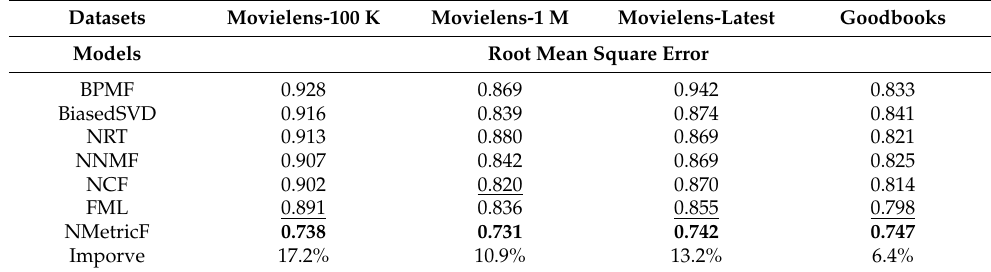
Table 2. RMSE comparison between NMetricF and baseline Models. (Best performance is in boldface and the second-best is